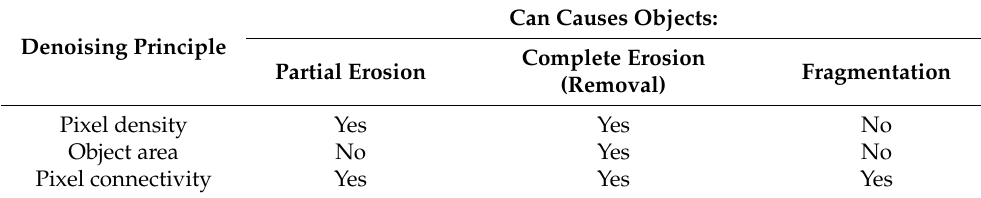
Table A2. Comparison of density-, area- and connectivity-based approach effects on objects erosion during